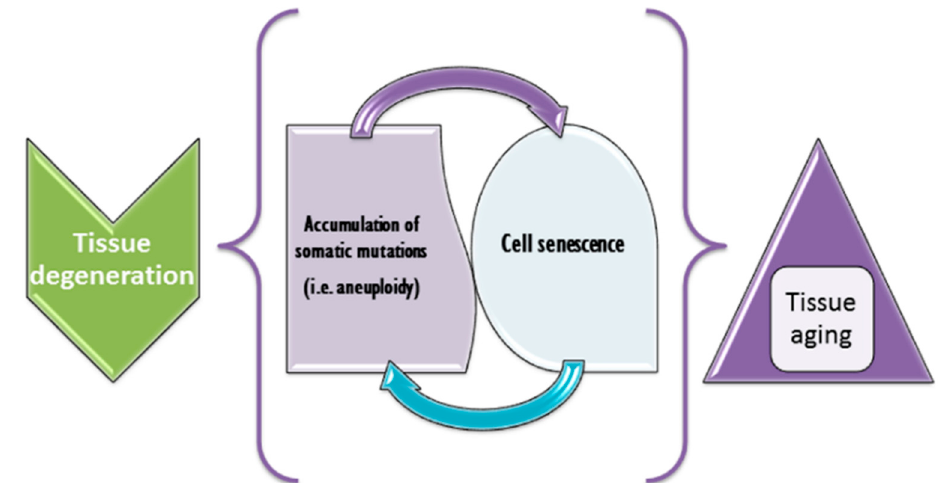
Figure 3. Hypothetical role of SCM / CIN in aging. It appears that accumulation of somatic mutations (e.g., aneuploidy, alterations to chromosome structure, repeat length variations, intragenic sequence changes, etc.) interplays with cell senescence. The result of this interplay might produce either aging at the tissular level or tissue degeneration, which is likely to be responsible for aging of an organism, as a whole.